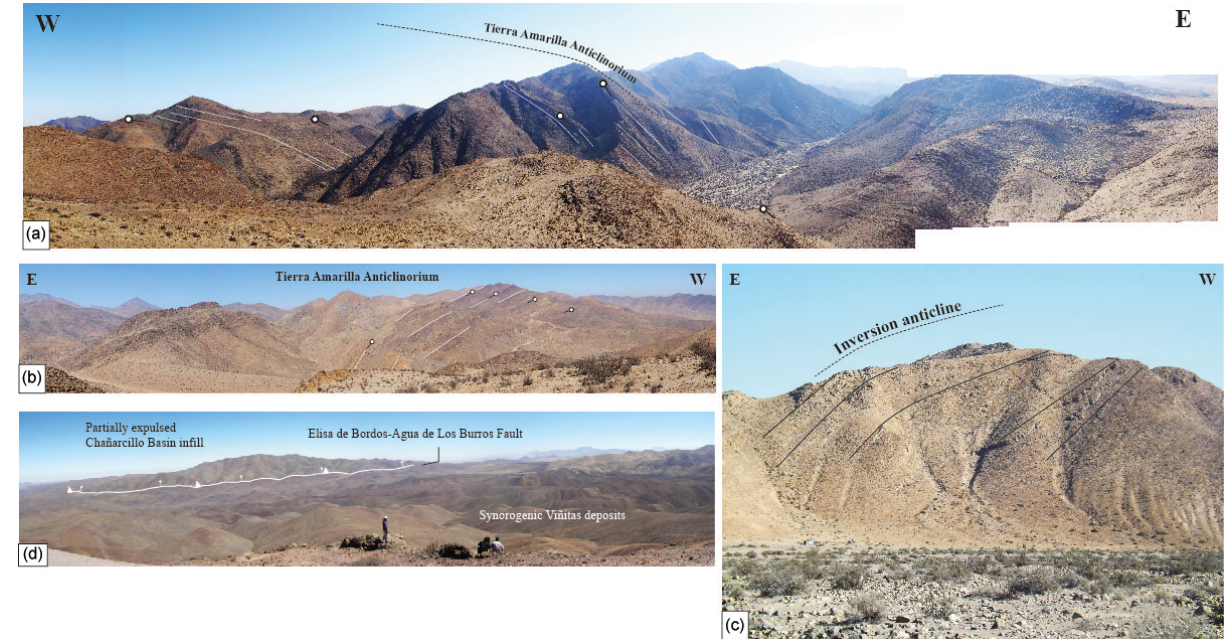
Figure 6. (a–b) W–E panoramic views of the east-vergent and long-wavelength Tierra Amarilla Anticlinorium involving the Chañarcillo Group (see location in Fig. 3); (c) oblique view of the Elisa de Bordos–Agua de Los Burros Fault System showing the contact between the synrift deposits of the Chañarcillo Group and the synorogenic deposits of the Viñitas Formation (see location in Fig. 3); (d) detail of the frontal limb of the Tierra Amarilla Anticlinorium (see location in Fig.